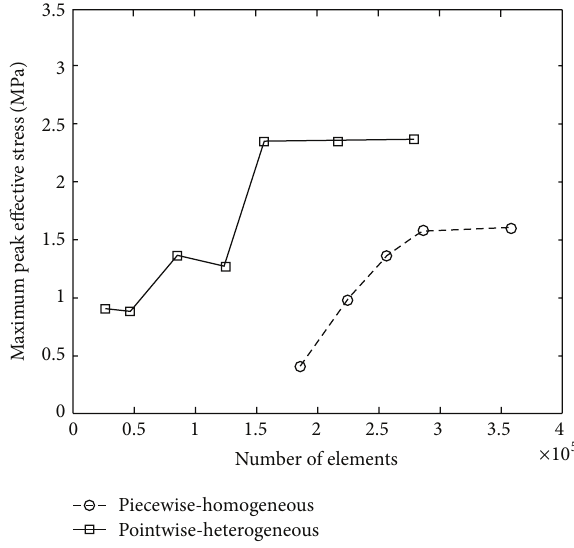
Figure 6: Convergence of maximum peak effective stress.